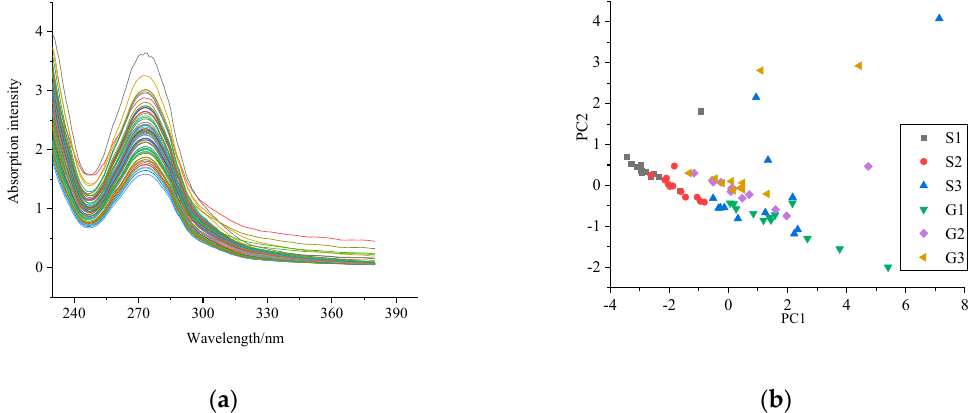
Figure 3. UV spectrum of samples: ( a ) the original UV spectra of samples and ( b ) the PCA plot of the UV spectrum of each grade.